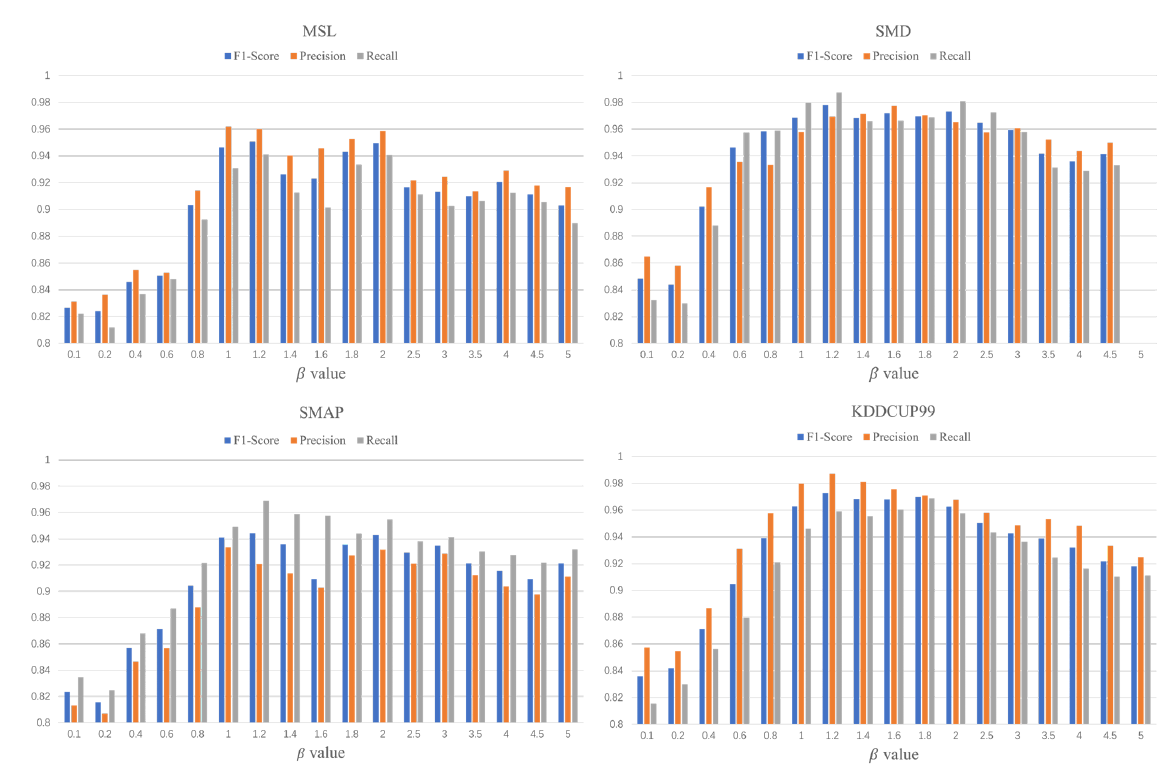
Figure 7. Detection effect of Anomaly-PTG